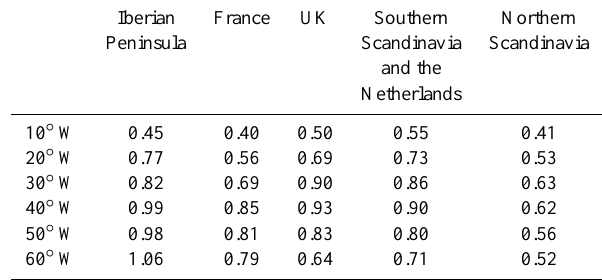
Table 3. ( E − P ) backward trajectories regions where the compu- tation is made for all the air parcels inside it.